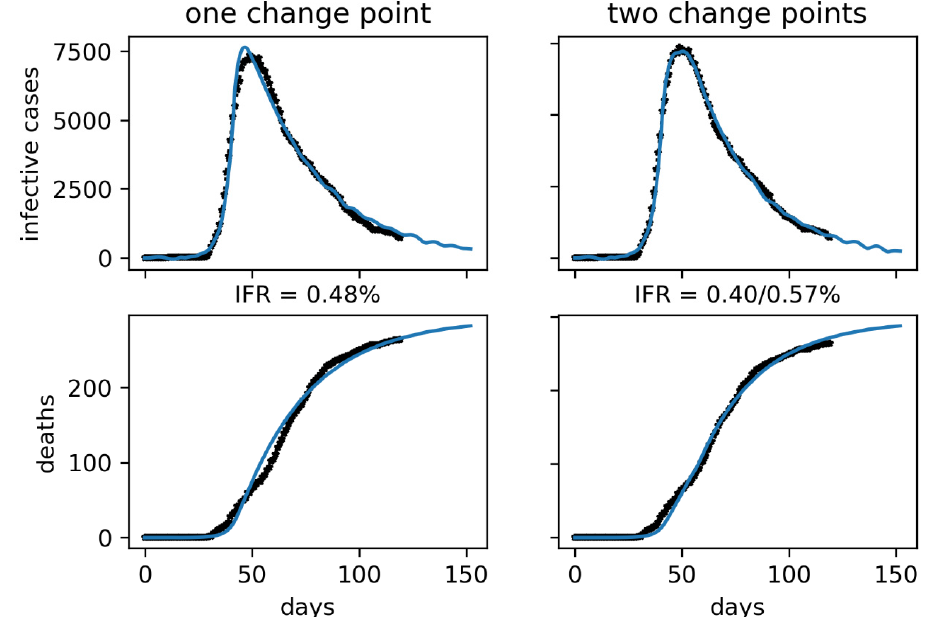
Figure 12. Korea fits. For the “one change point” model, we use the data of active cases (infective in the model) and adjust the transmissivity rate ( β ) and the containment factor ( ρ ) but also the infectious period ( γ − 1 ). We find the best fits at γ − 1 = 5.4 days, being consistent with the values proposed by [22]. For the second set, we use γ as a fixed parameter to find again the new values of β and ρ . For each case, series of confirmed